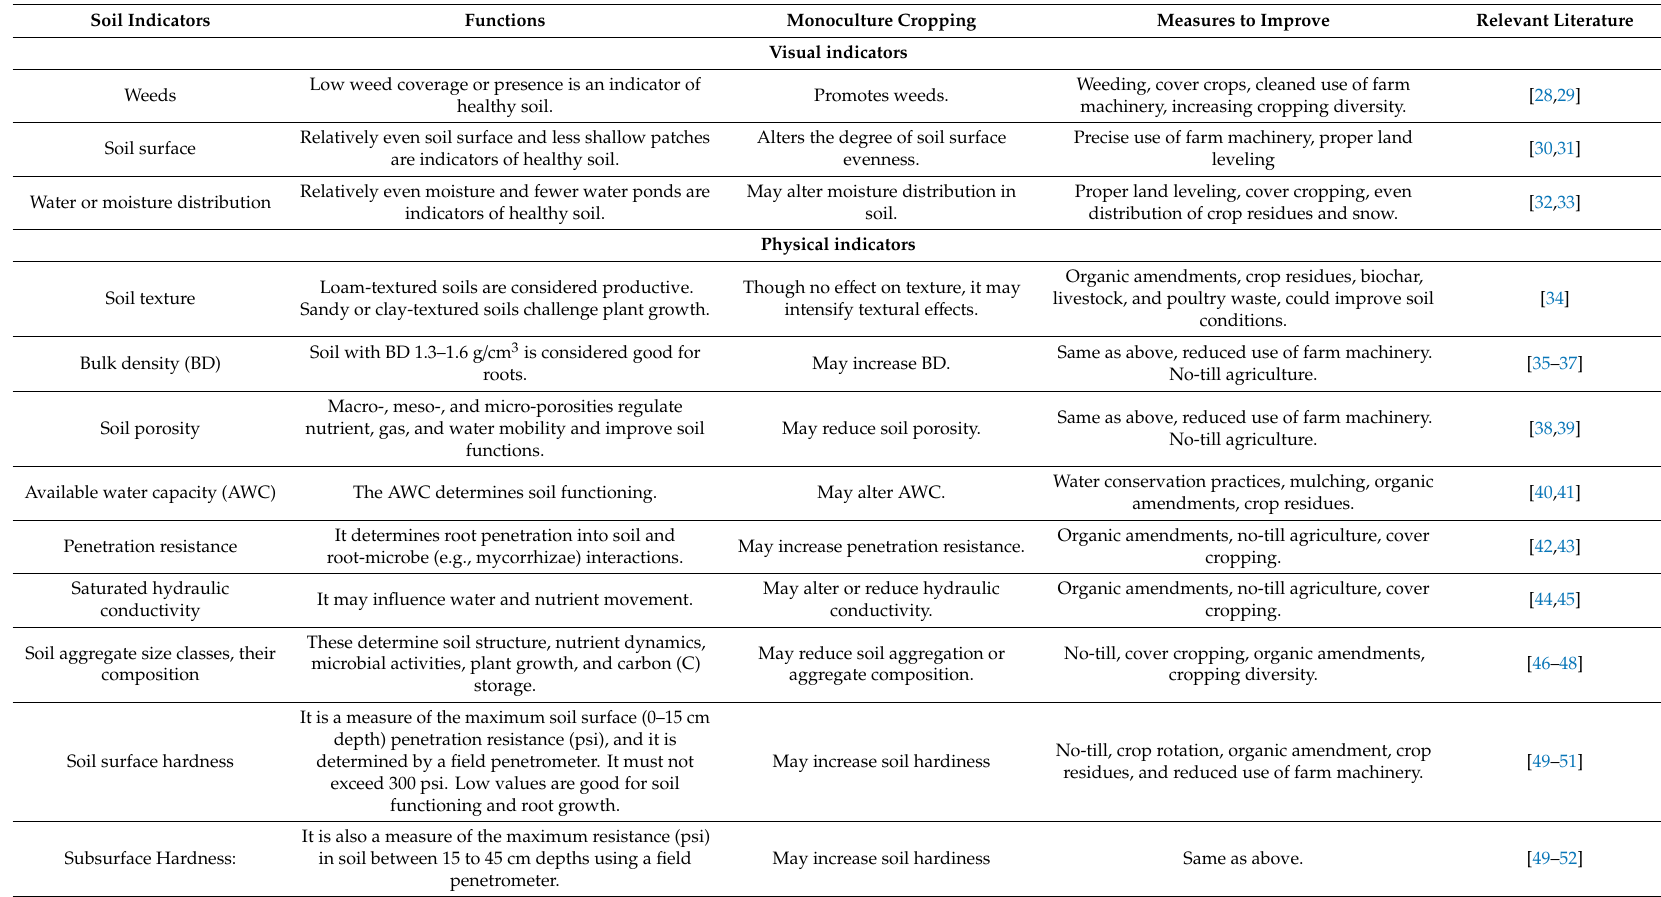
Table 1. A brief overview of key indicators of soil